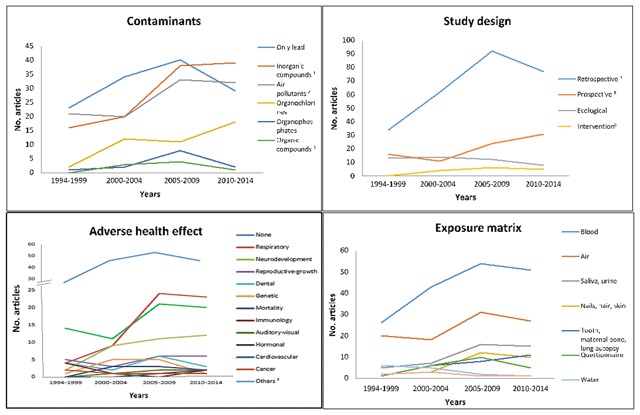
Articles of environmental child’s health by year and selected characteristics (n = 409).1 Arsenic, fluorine, manganese, iron, selenium, zinc, mercury, chromium, nickel, silver, gold, cadmium, barium, cobalt, lead, molybdenum; 2 Ozone, PM, carbon oxides, sulfur oxides, nitrogen oxides, polycyclic aromatic hydrocarbons, volatile organic compounds; 3 Polybrominated compounds, phthalates, petroleum hydrocarbons; 4 Retrospective panel cross-sectional, case-control, retrospective cohort; 5 Prospective panel, case-cohort, nested case-control, prospective cohort; 6 Randomized and non-randomized trials; 7 Erythro porphyrin levels, bilirubin, calcium absorption, cholinesterase activity, biomarkers of inflammation.